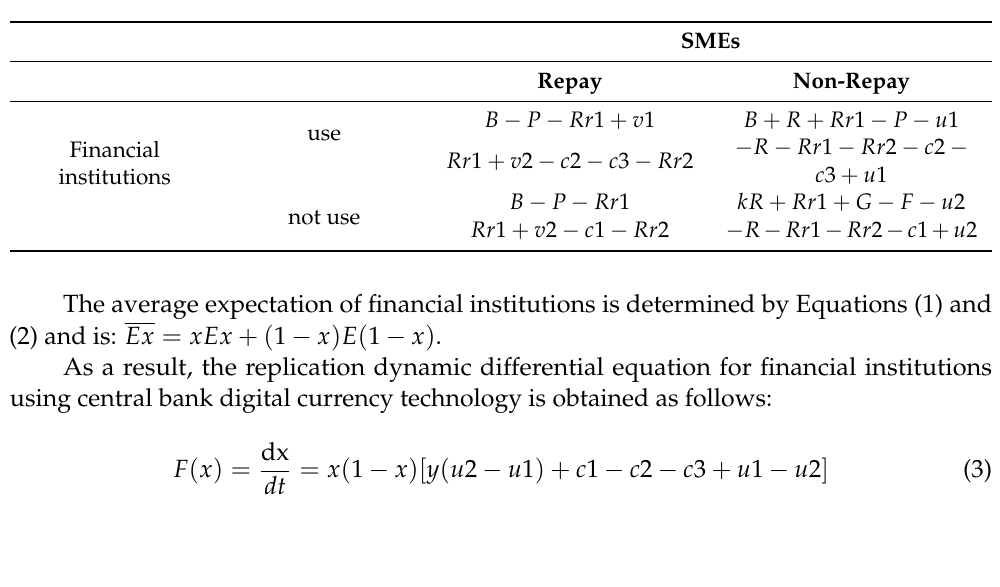
Table 2. Benefit matrix for SMEs and financial institutions.